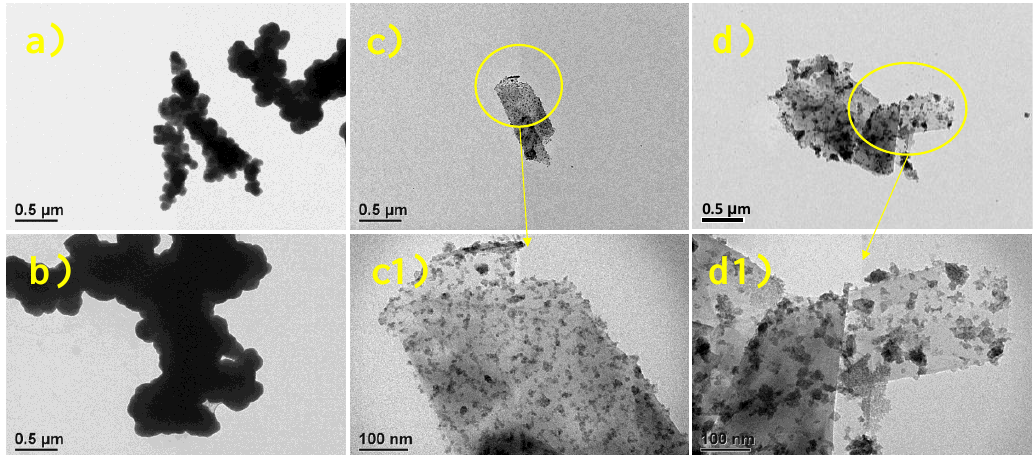
Figure 1. TEM images of as-synthesized ZnS photocatalysts with different amounts of MoS 2 /graphene (MSG): ( a ) 0 wt.%, ( b ) 0.1 wt.%, ( c ) 0.5 wt.%, ( c1 ) enlarged ( c ), ( d ) 1.0 wt.%, ( d1 ) enlarged ( d ).